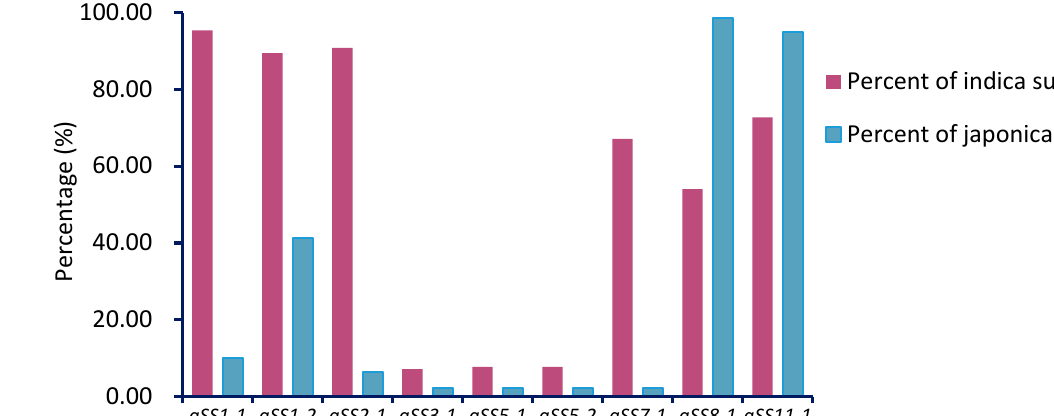
Figure 7. Comparison of the frequency of these QTLs superior alleles in indica and japonica subspecies.